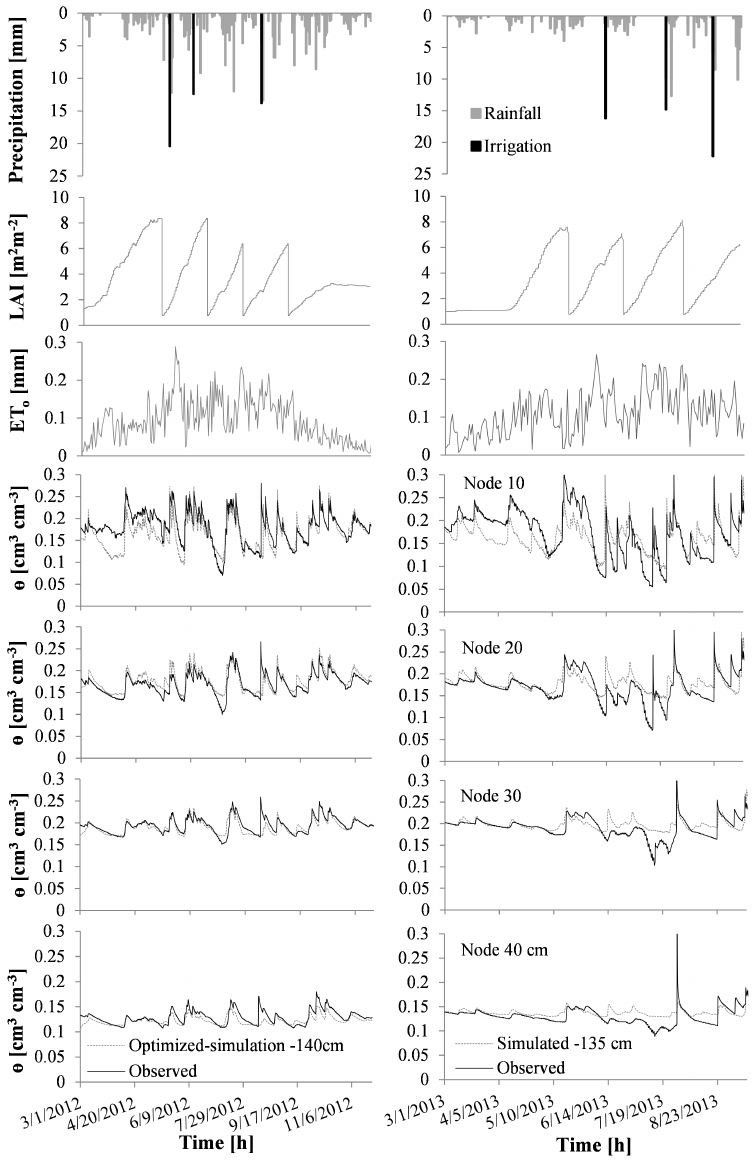
Figure 5. Observed and simulated time series of soil water content with calibration using the two-parameter K s scenario for 2012 and validation results of